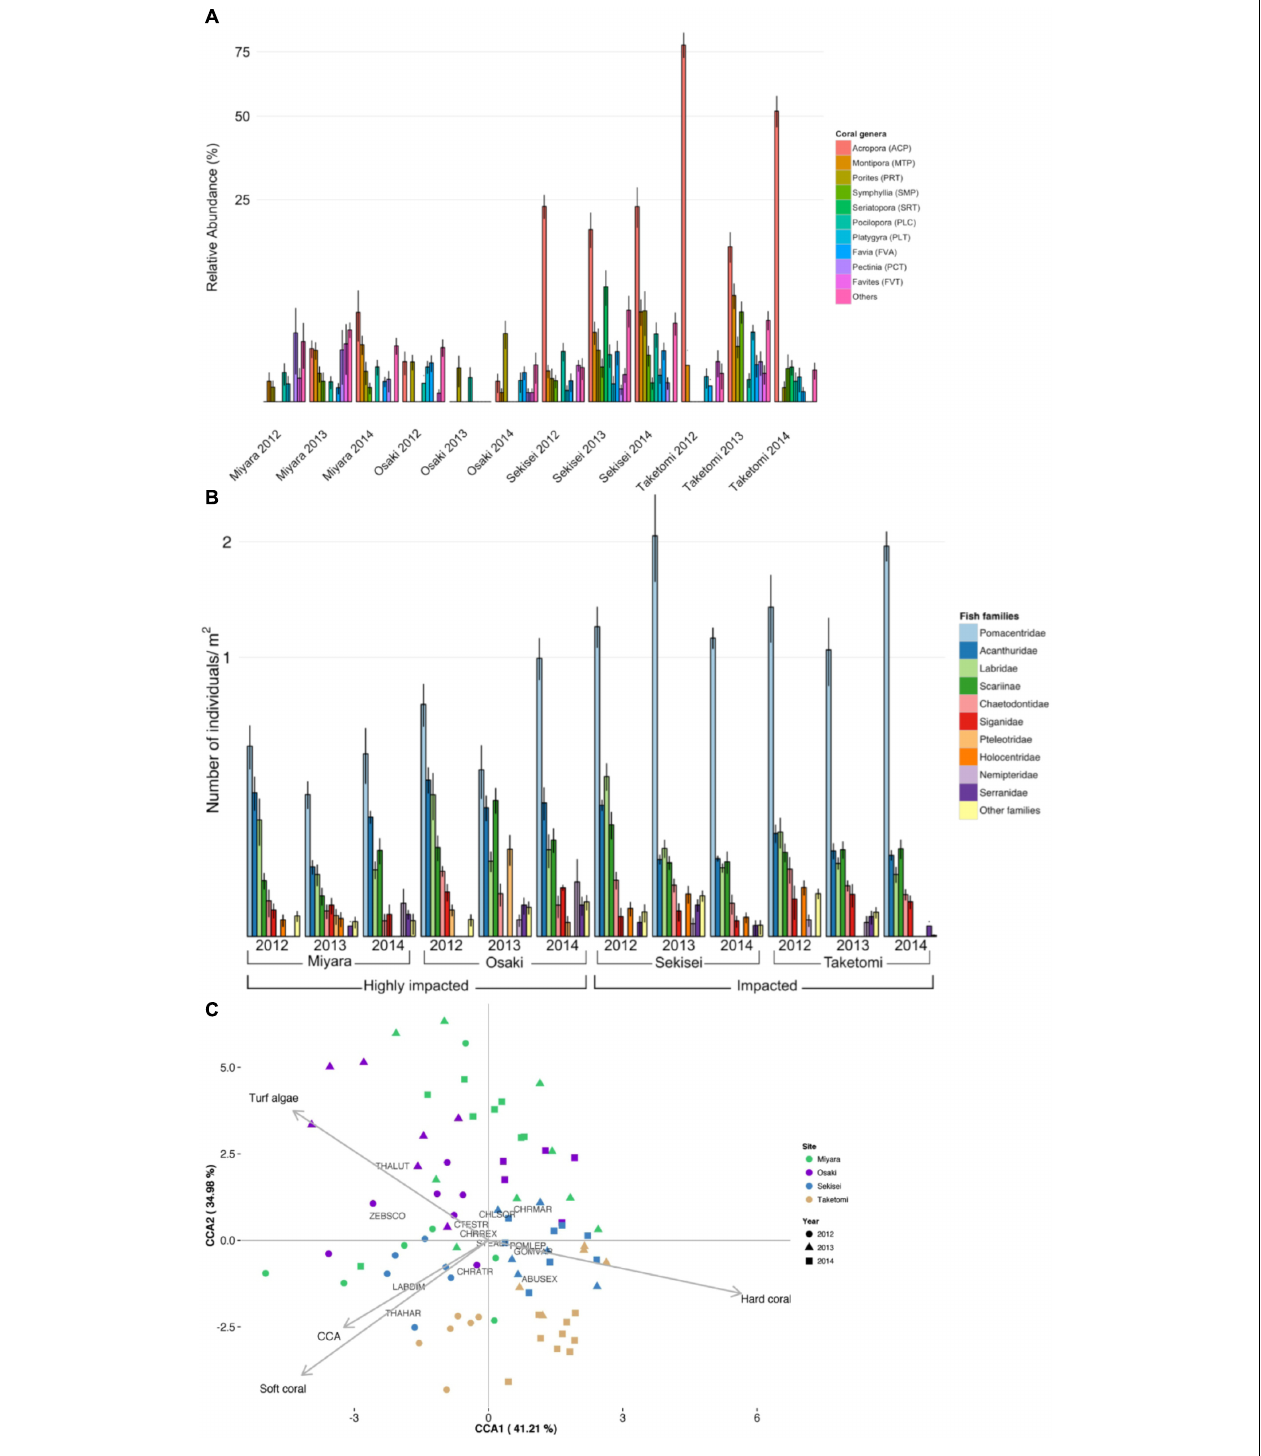
FIGURE 3 | Ishigaki coral reef and fish community composition structure. (A) Relative coral cover. (B) Relative abundance of fish families. (C) Canonical correspondence analysis (CCA) biplot of benthic cover and fish assemblages of Ishigaki coral reefs. Each replicate is represented by dots in different colors (for sites) and different shapes (for years). Species abbreviations are: CTESTR, Ctenochaetus striatus ; STEALT, Stegastes altus ; CHLSOR, Chlorurus sordidus ; POMLEP, Pomacentrus lepidogenys ; CHRMAR, Chromis margaritifer ; CHRREX, Chrysiptera rex ; CHRATR, Chromis atripectoralis ; ABUSEX, Abudefduf sexfasciatus ; THALUT, Thalassoma lutescens ; THAHAR, Thalassoma hardwicke ; GOMVAR, Gomphosus varius ; LABDIM, Labroides dimidiatus ; ZEBSCO, Zebrasoma scopas .